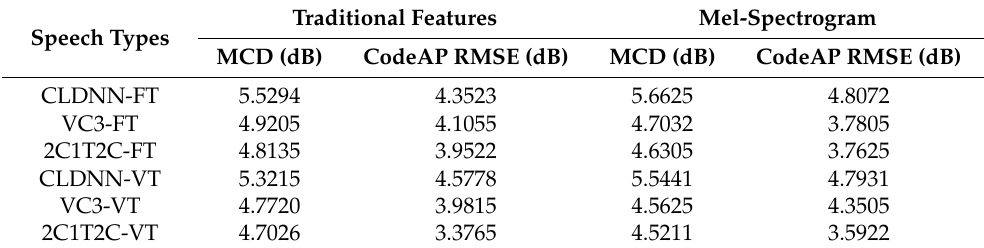
Table 4. Objective evaluations of spectrum